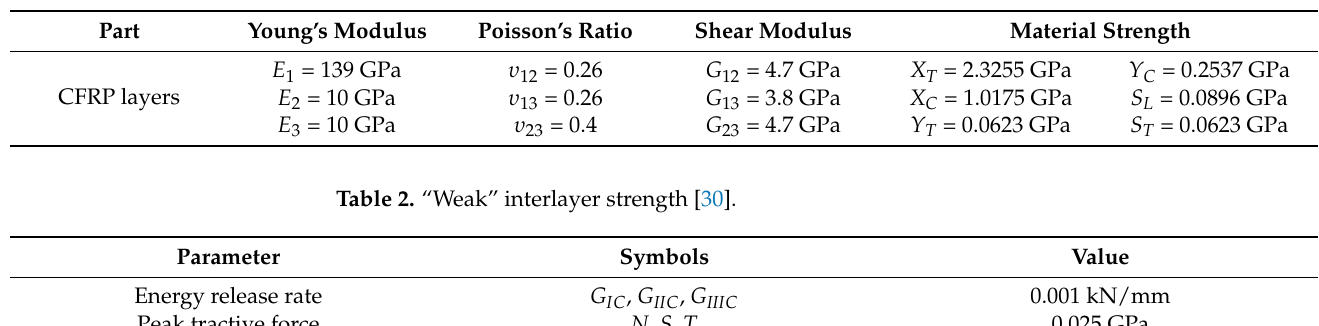
Table 1. Used material properties to compute the failure envelopes for the CFRP material [9]. Re-